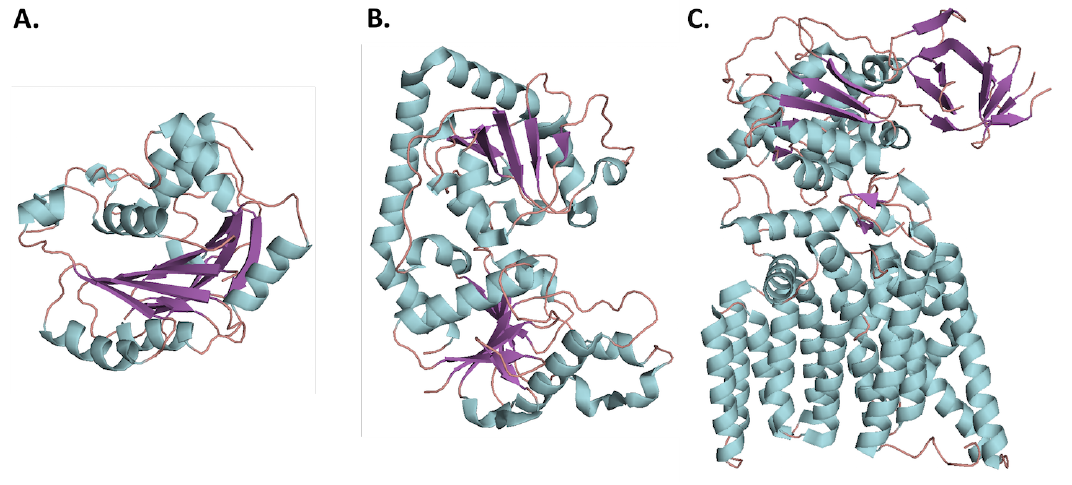
Figure 2. Representative folds of the first glycosyltransferase (GT) enzymes crystallized in each structural family: loops, α -helices, and β -sheets are colored salmon, cyan, and purple respectively. ( A ) GT-A fold represented by SpsA from Bacillus subtilus , PDB: 1QGQ; ( B ) GT-B fold represented by bacteriophage T4 β -glucosyltransferas, PDB: 1JG7; ( C ) GT-C fold represented by PglB from Campylobacter lari , PDB: